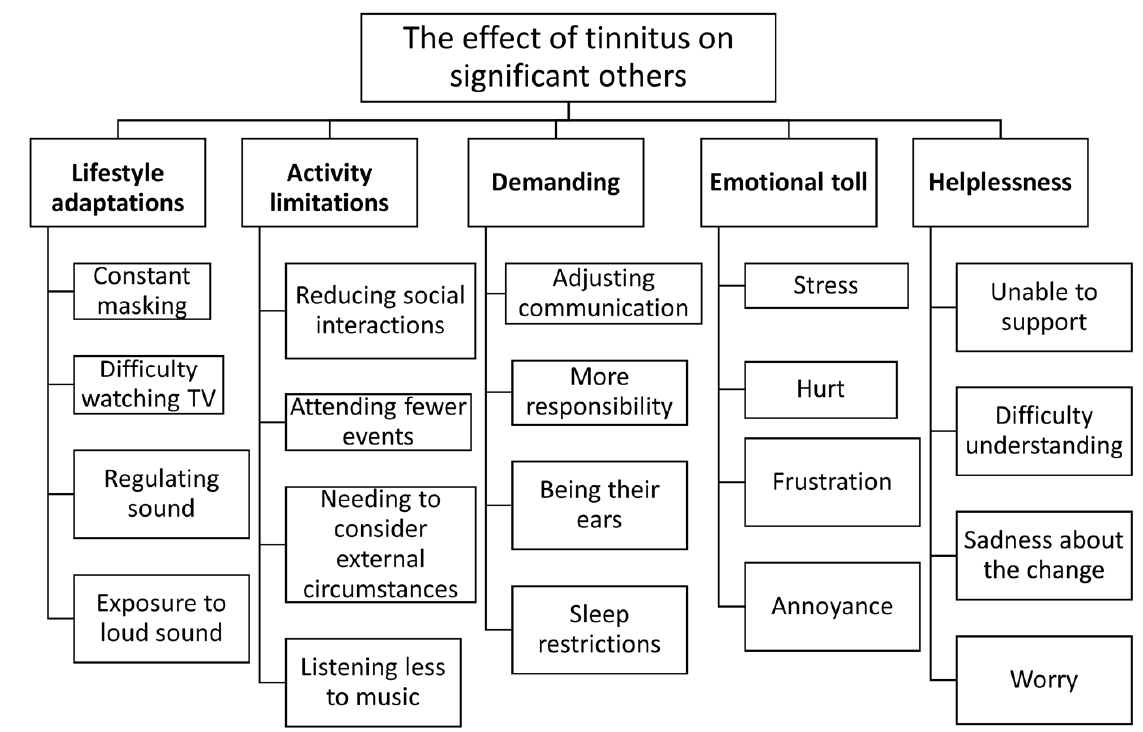
Figure 1. The effect of tinnitus on significant others.